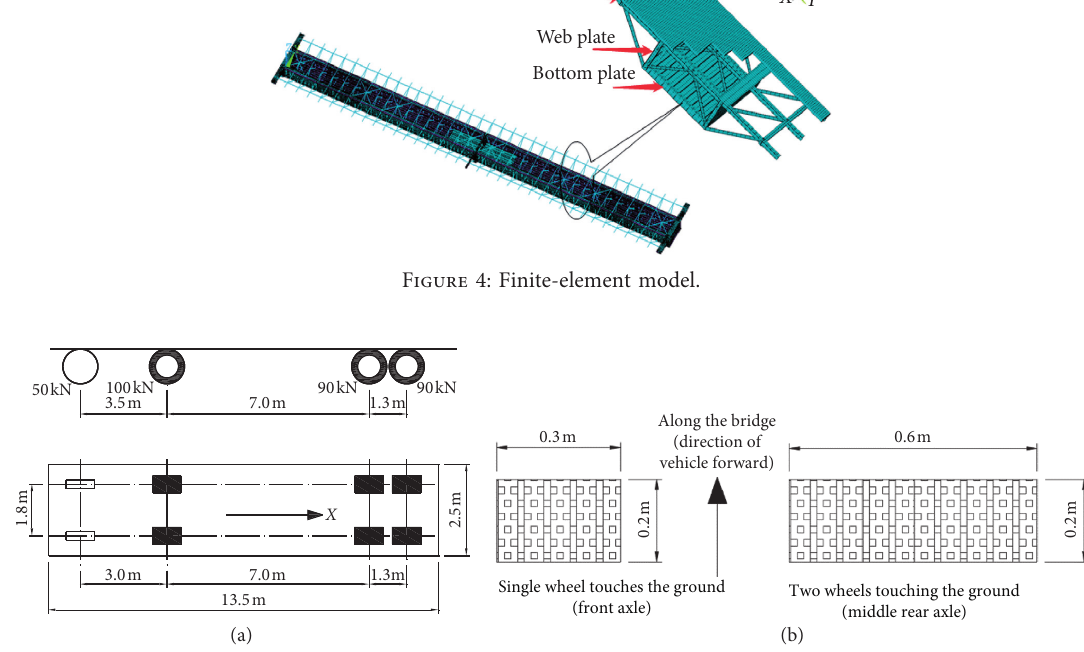
Figure 5: Fatigue design load model. Note: indicates a single wheel on each side, indicates two wheels on each side, and X refers to the direction along the bridge.